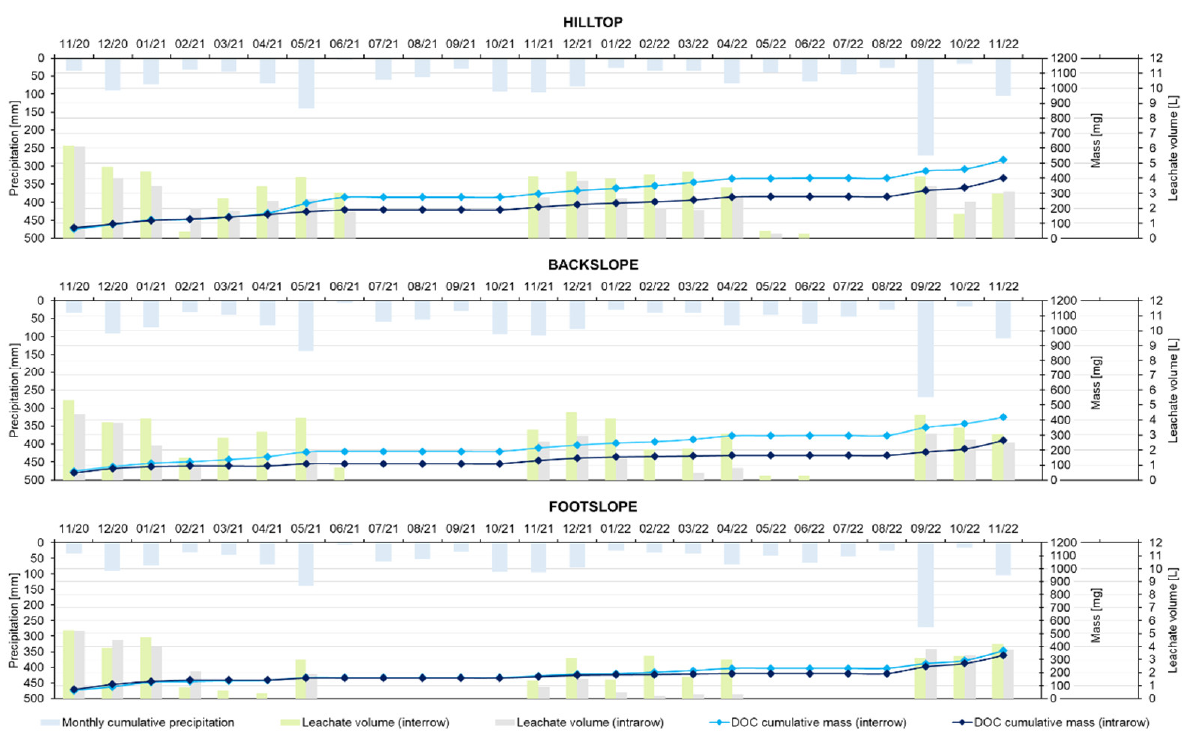
Figure 4. Dissolved organic carbon cumulative mass (mg) in leachates, collected for two years (2 November 2020–25 November 2022), from lysimeters installed at hilltop, backslope and footslope of vineyard inter- and intra-row, presented with monthly cumulative precipitation and leachate volumes per sampling